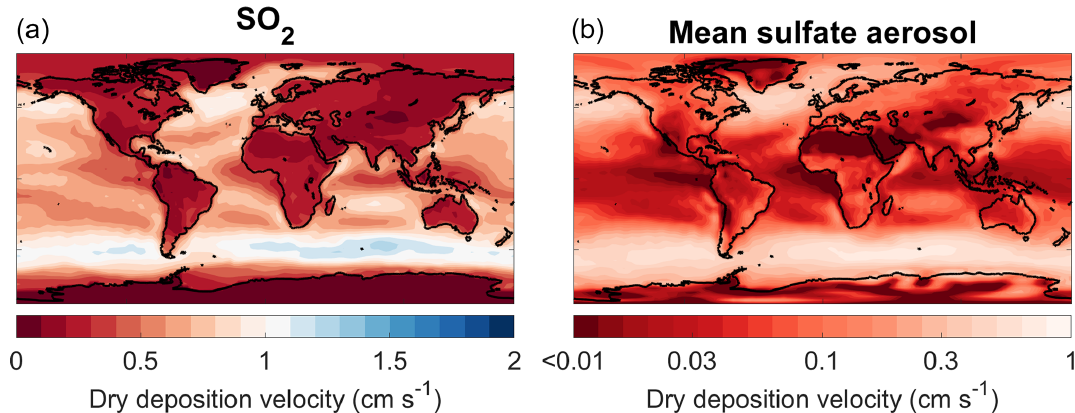
Figure 1. Annual mean dry deposition velocities for SO 2 (a) and sulfate aerosol (b) simulated by SOCOL-AERv2. The mean dry deposition velocity for aerosol particles is calculated by weighting the dry deposition velocity for each size bin with the bin’s mass concentration at the surface. The color bar highlights differences between the newly simulated deposition velocities and the former homogeneous deposition velocity of 1cms − 1 , which is shown in whitish colors on both